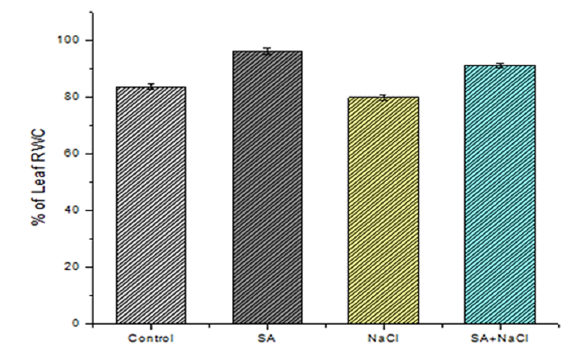
Figure 3. Relative Water Content (RWC): Relative water content of both individual and combined effect of salinity and SA. X axis-Treatment group; Y axis- Percentage of leaf RWC Values are expressed as mean ± SD, n=3 in each group.